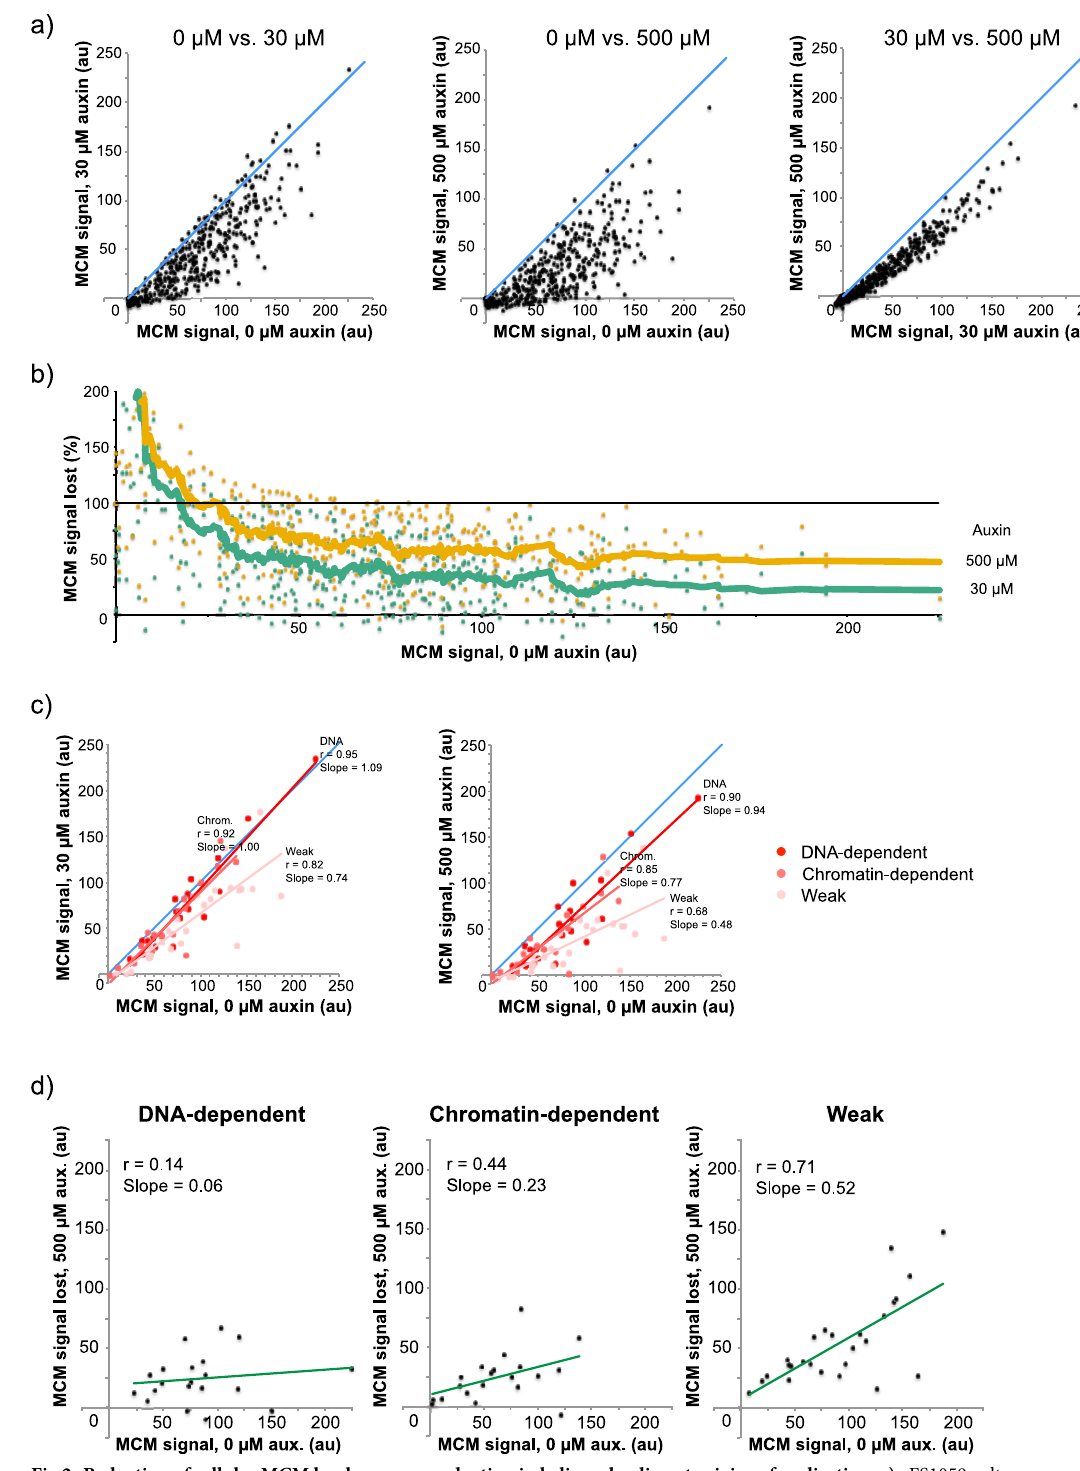
Fig 2. Reduction of cellular MCM levels causes a reduction in helicase loading at origins of replication. a) yFS1059 cultures were synchronized and released into S phase as shown in Fig 1A. MCM ChIP-seq signal in 1 kb bins around ARS-annotated origins from the indicated auxin treatments at the α -factor arrest point (x = y line drawn in blue for reference). b) Percent of MCM ChIP-seq signal lost upon treatment with 30 μ M or 500 μ M auxin. (20 pt moving average fit. y = 100 line drawn in blue for reference). c) MCM ChIP-seq signal at 0 μ M auxin treatment compared to 30 μ M and 500 μ M auxin for origins of replication characterized as ‘DNA-dependent’,